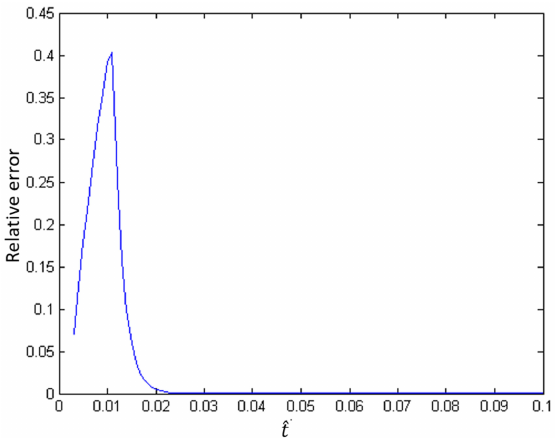
Figure 5. Comparison of the displacement (left) and pore pressure at time ˆ t = 3 × 10 − 5 with hybrid splitting (continuous blue line) and fully coupled (discontinuous red line) methods with nine iterations for linear material coefficients.